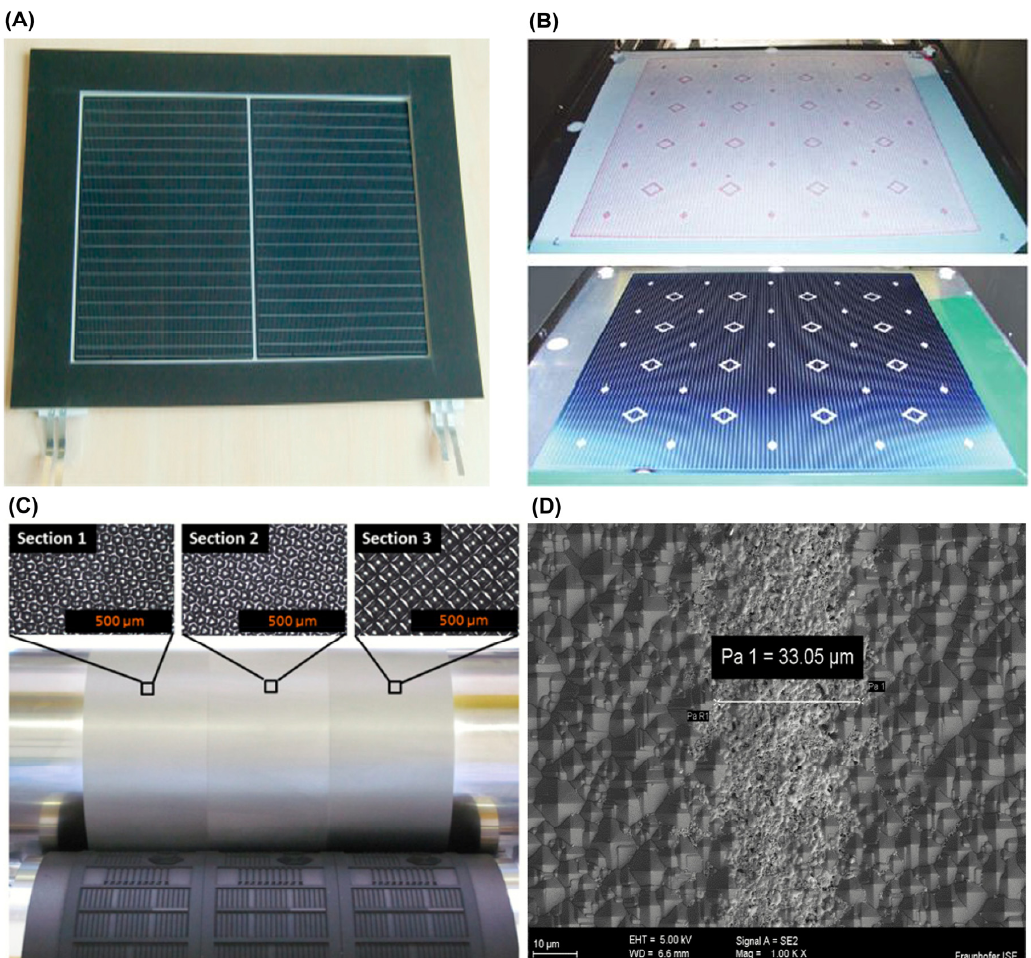
Figure 3. ( A ) Fabricated mini-module using two flexo-printed solar cells with SmartWire intercon-